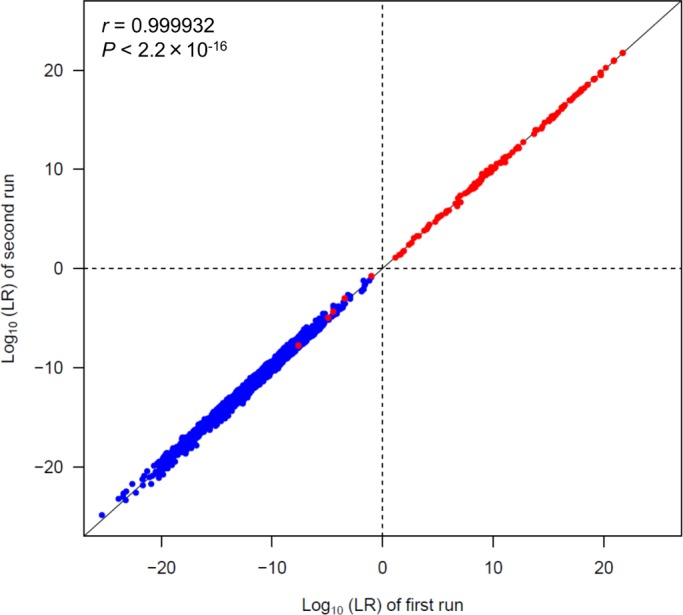
LR values of two runs.The red and blue plots represent the results of true-contributor and non-contributor testing, respectively. The black line represents the x = y diagonal line and r is the correlation coefficient obtained by Pearson’s product-moment correlation test.